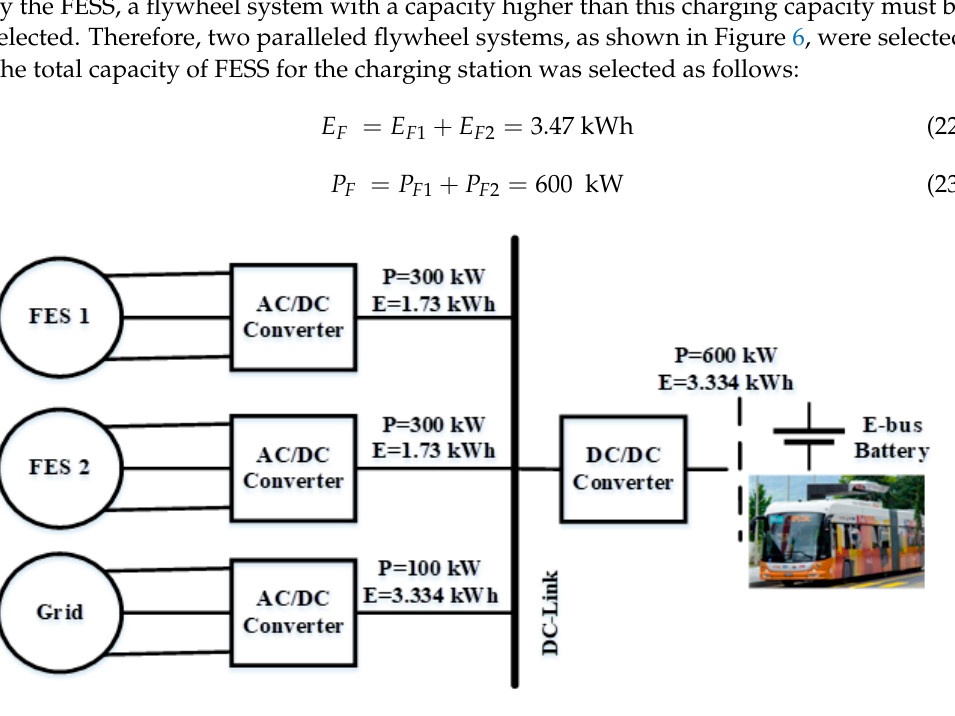
Figure 6. Proposed electric bus flash charging station.